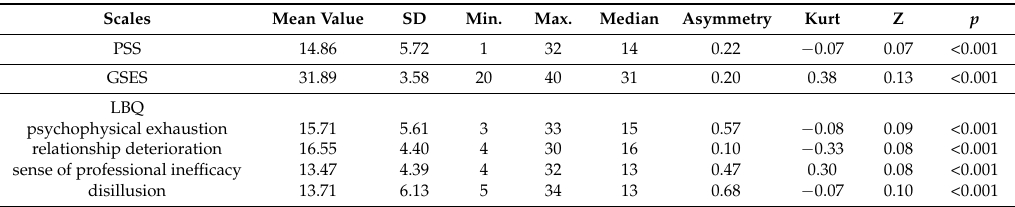
Table 3. Descriptive statistics for the Perceived Stress Scale (PSS), the General Self-Efficacy Scale (GSES), and Link Burnout Questionnaire (LBQ) ( N = 580).